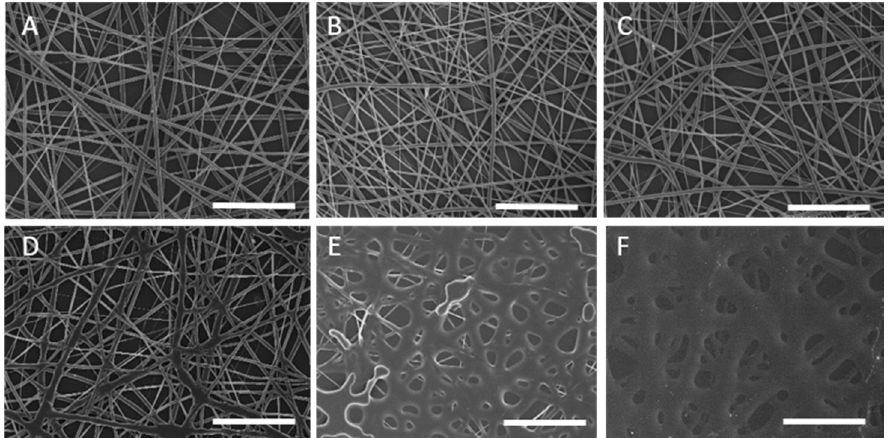
Figure 3. Field emission scanning electron microscope (FESEM) micrographs of the polyethylene terephthalate (PET) films coated with electrospun polylactide (PLA) fibers and annealed at different temperatures: ( A ) Without annealing; ( B ) 90 °C; ( C ) 120 °C; ( D ) 140 °C; ( E ) 160 °C; ( F ) 170 °C. The annealing time was 15 s in all samples and scale bars are 50 µm.